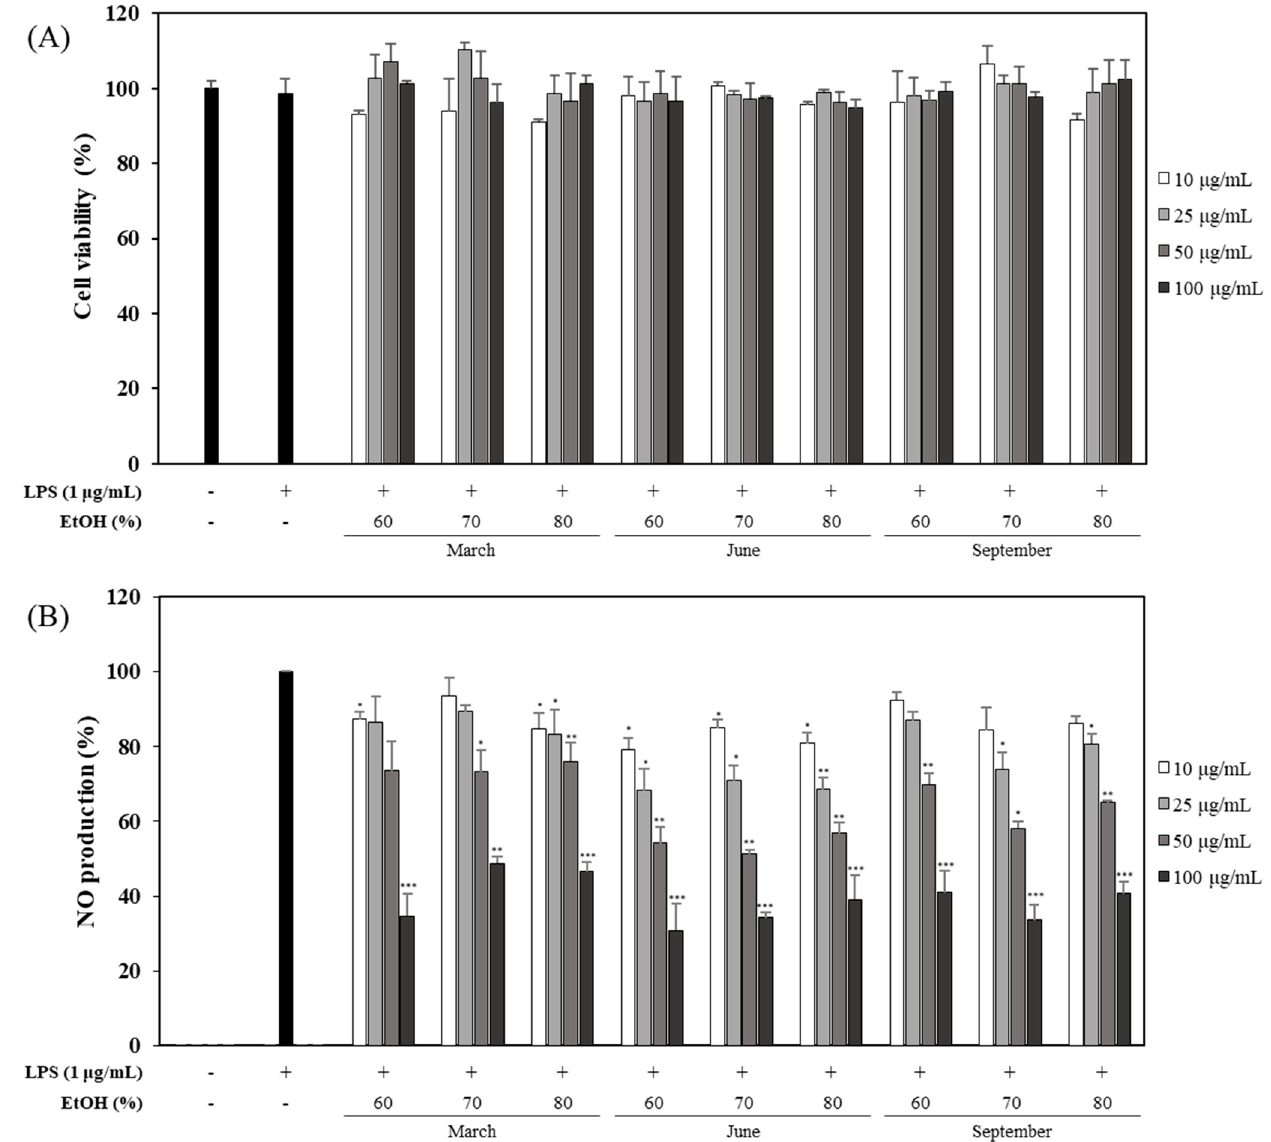
Figure 2. Effects of OFLEs obtained from leaves with different harvest time and various solvent ratios on cell viability and NO production. Inhibitory effects of different harvest time OFLE (10, 25, 50, and 100 µ g/mL) by solvent ratio in LPS-induced RAW 264.7 cells. Cells were treated with each extract for 1 h and then stimulated with LPS (1 µ g/mL) for 20 h. Cytotoxicity ( A ) was determined by MTT assay. Culture media were evaluated for NO production ( B ) using Griess reagent. Each determination was conducted in triplicates. Data are represented as mean ± SD. * p < 0.05, ** p < 0.01, *** p < 0.001 vs. LPS-treated group.